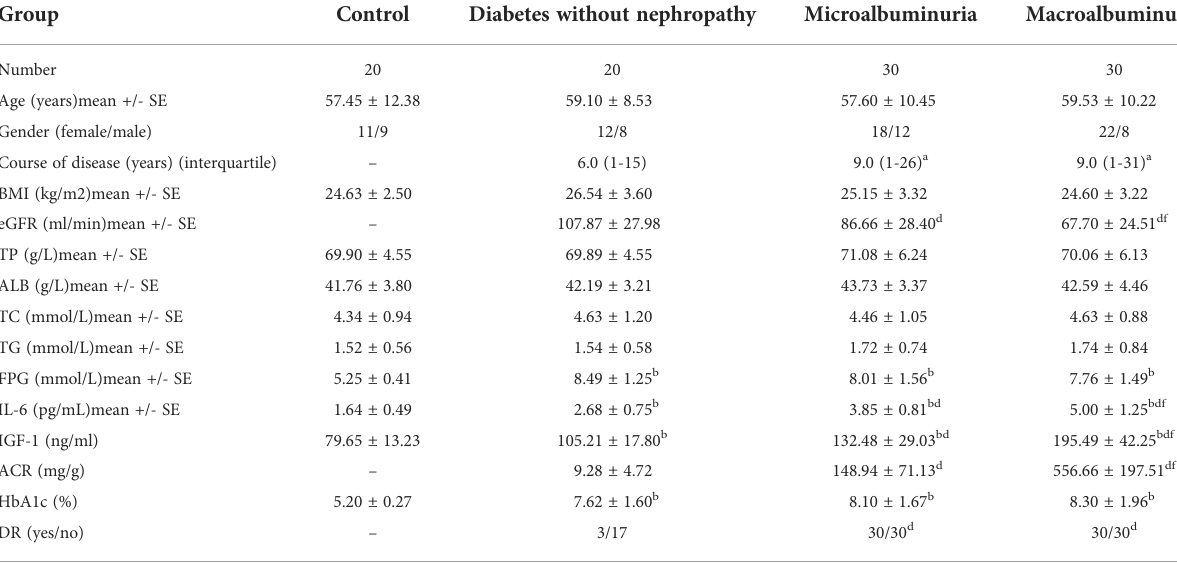
TABLE 1 Clinical data comparison between the control group and the experimental group. Group Control Diabetes without